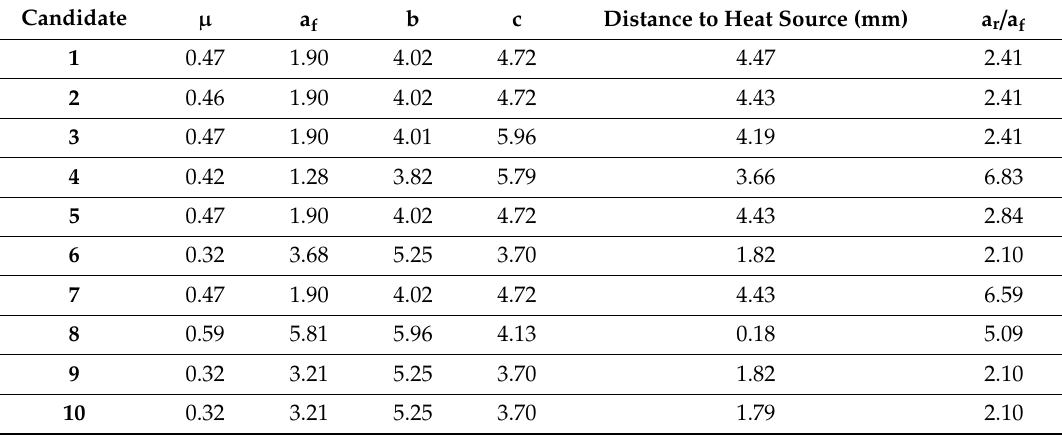
Table 7. Optimal value candidates created by the optimal